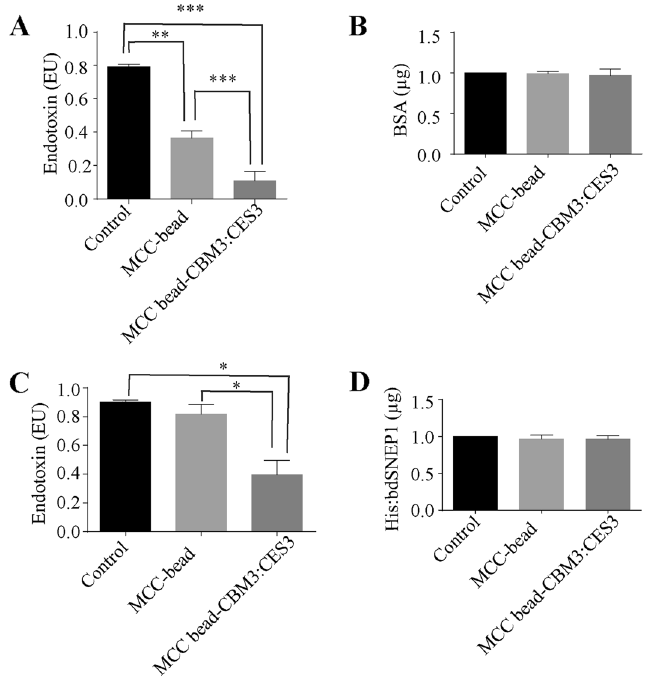
Figure 6. CES3:CBM immobilised onto MCC beads removes LPS from protein samples. ( A , B ) LPS removal from artificially constituted LPS/BSA mixture. An artificial mixture of LPS ( E . coli O111:B4) and BSA was prepared by mixing 0.9 EU of LPS and 1 µg BSA in 1 mL and incubated with MCC beads only and CES3:CBM3- immobilised MCC beads for 30 min at room temperature. MCC beads were precipitated by brief centrifugation, and the MCC beads and supernatant were collected separately. The amount of LPS present in the supernatant was measured using the LAL test kit and calculated using the standard curve ( A ). The amount of BSA in